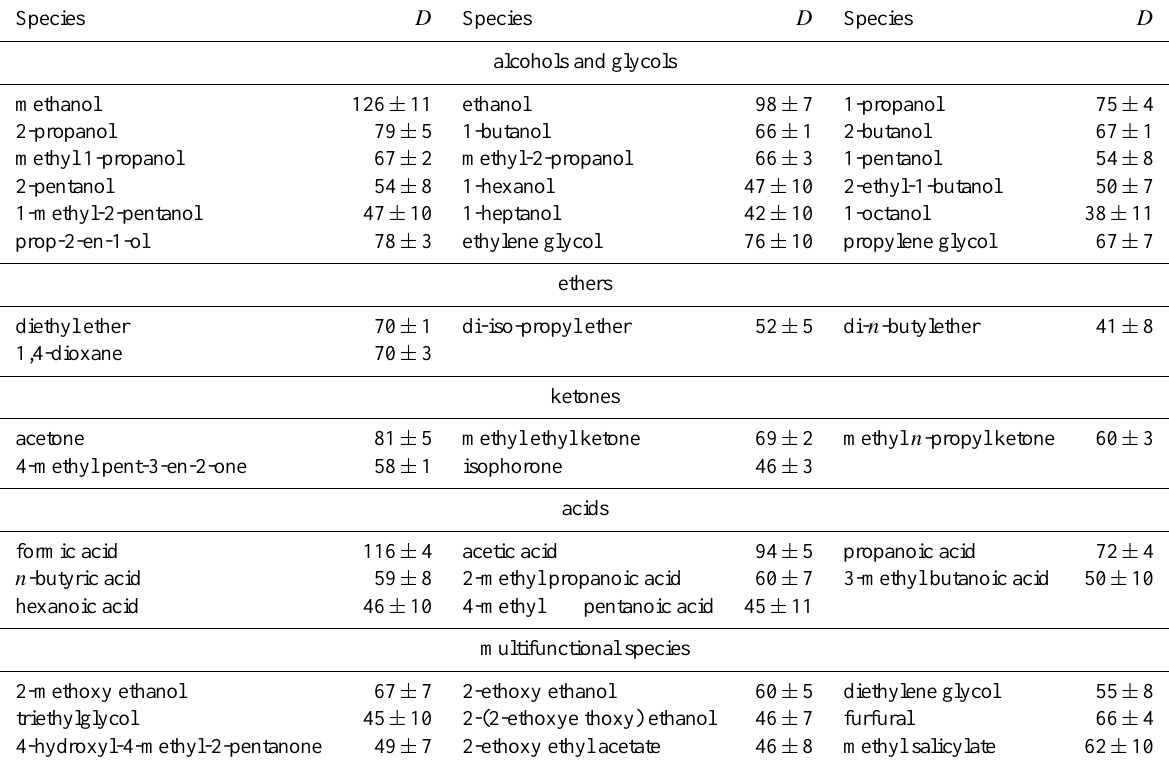
Table 2. Summary of preferred diffusivities ( D , Torrcm 2 s − 1 ) at 298K: alcohols, glycols, ethers, ketones, acids, and multifunctional species. The uncertainties given to preferred values are explained in Sect.